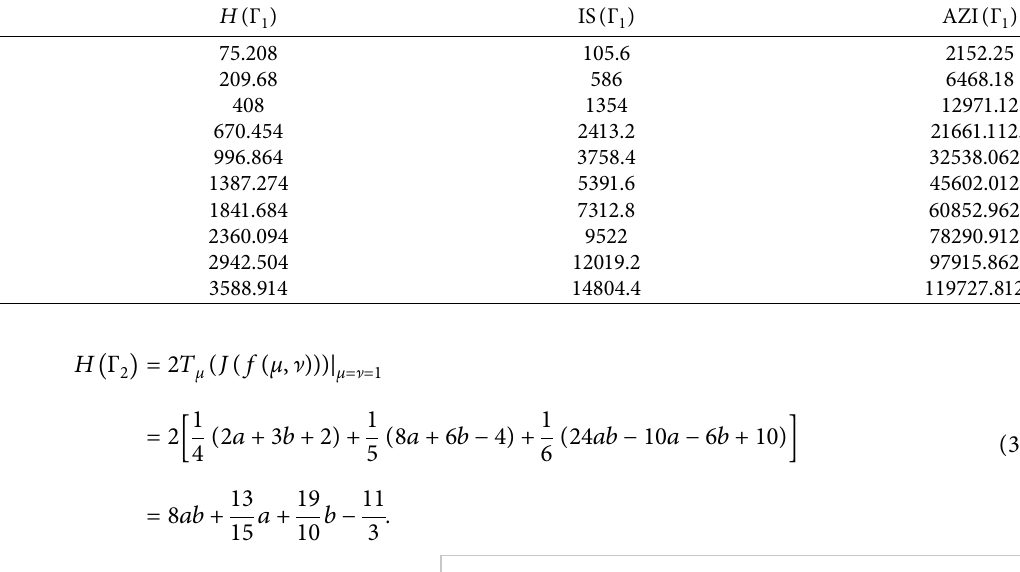
) of HC 2 ) , and AZI ( Γ 1